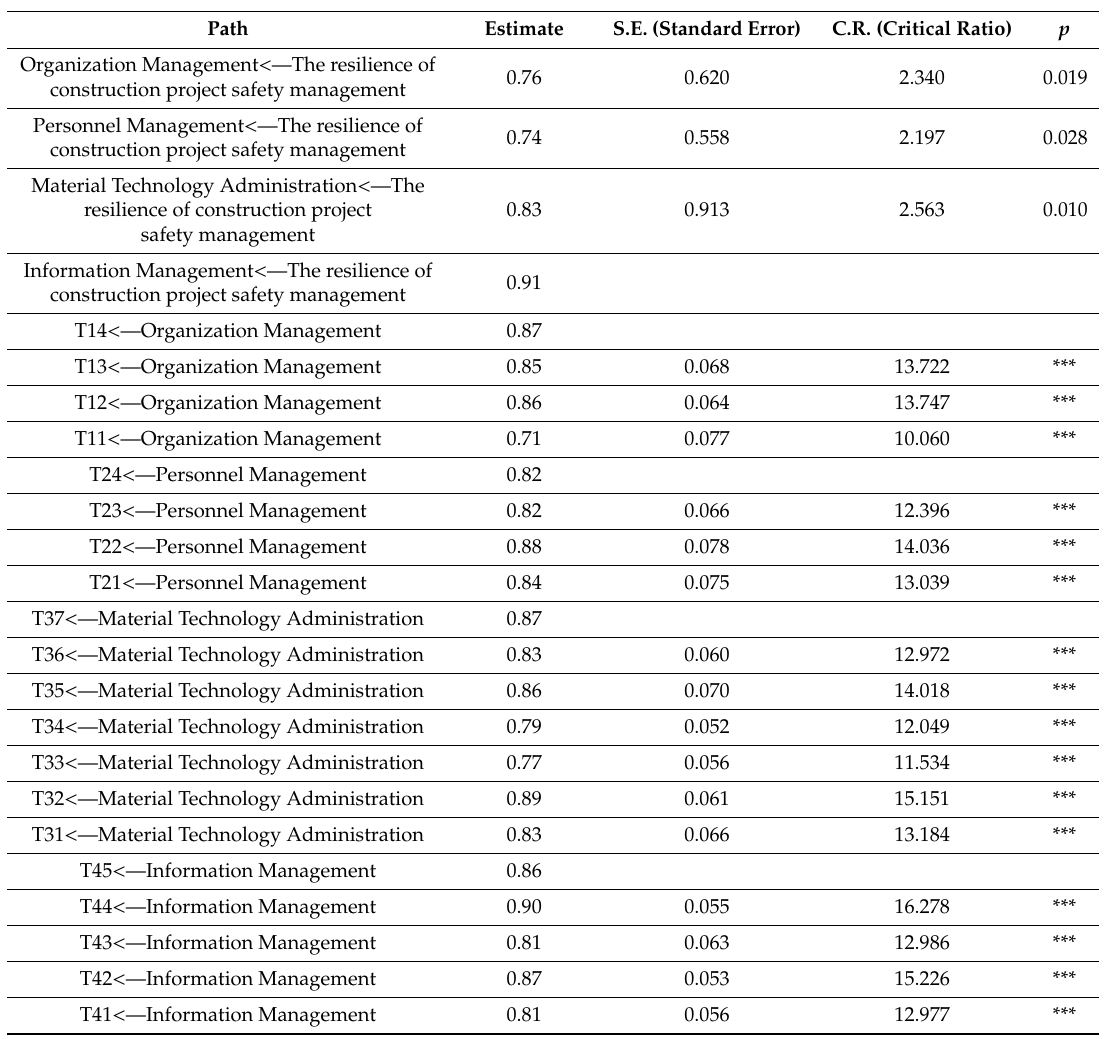
Table 8. Regression